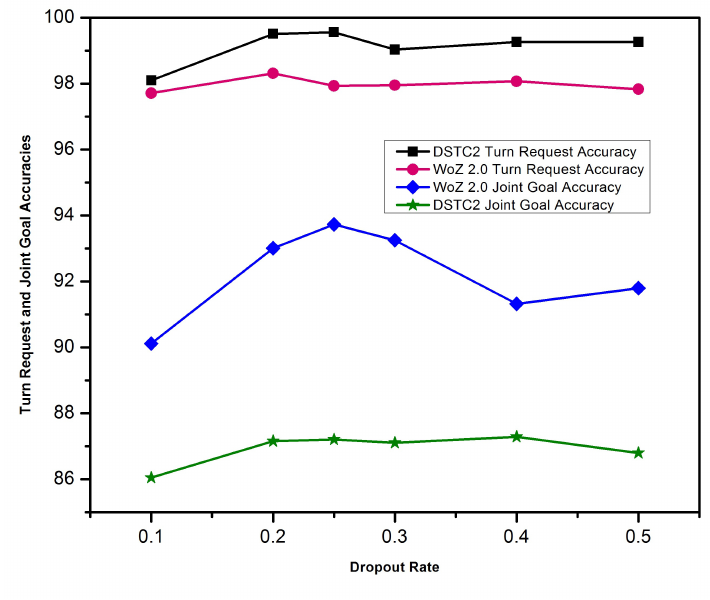
Figure 7. Impact of Dropout